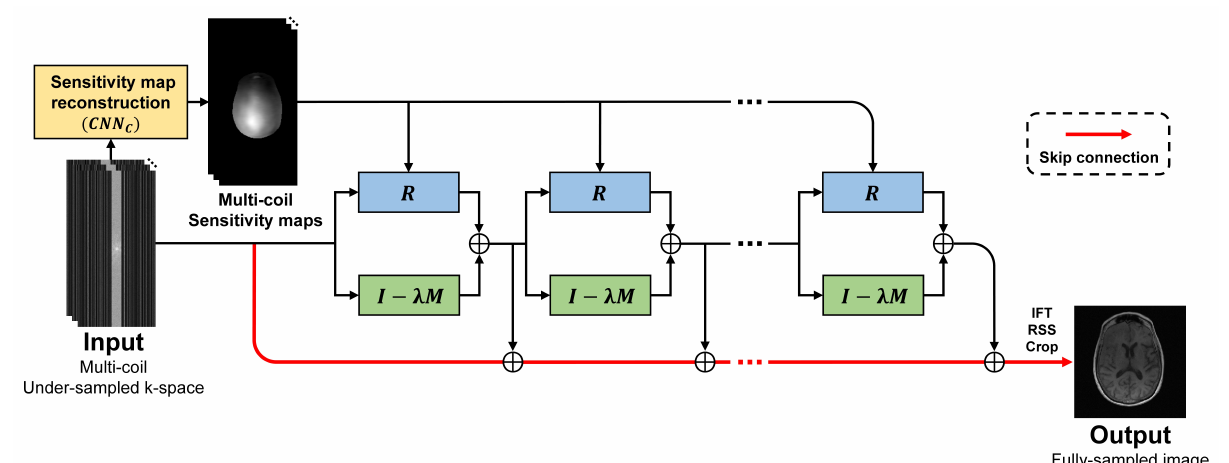
Figure 1. The overall architecture of the multi-domain Neumann network with sensitivity maps. The CNN-based sensitivity map reconstruction block reconstructs coil sensitivity maps from multi- coil under-sampled k-space. The block marked with ( I − λ M ) is a data consistency block. The regularization block R reconstructs an MR image. The outputs of each iteration are accumulated in skip connections to become the final